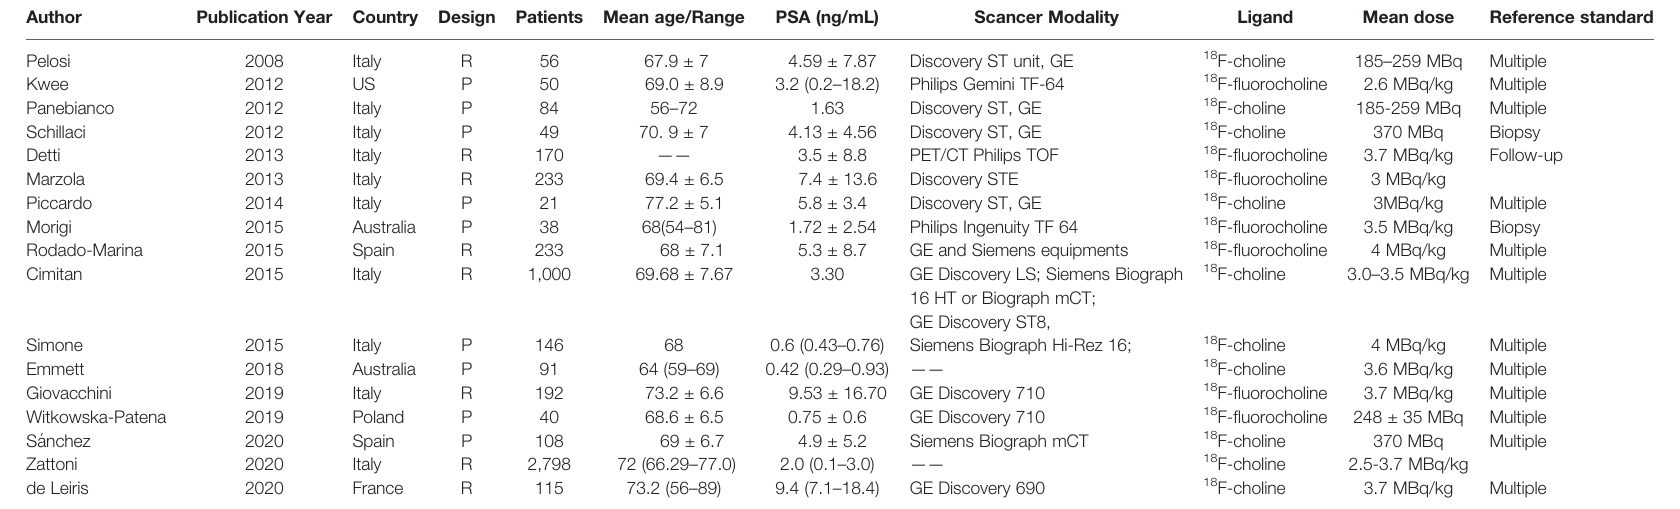
TABLE 1 | Study characteristics of 18 F-choline